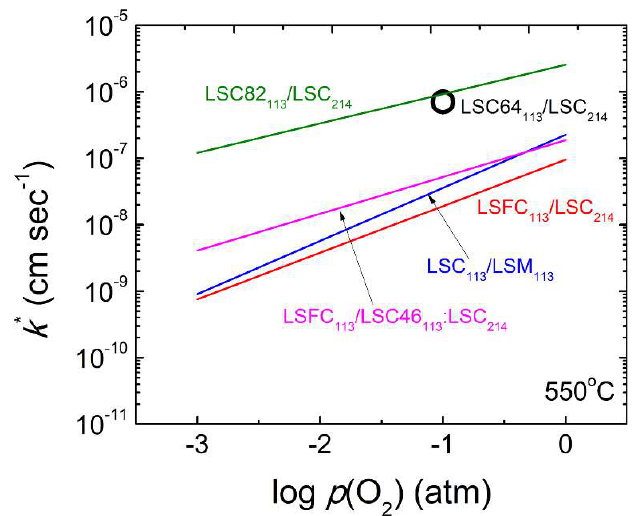
Figure 11. Arrhenius plots of surface exchange coefficients (k*) for various heterostructure oxide thin films. Effect of heterostructure interfaces on k * for La 0.6 Sr 0.4 CoO 3-δ /(LaSr) 2 CoO 4±δ [150], La 0.625 Sr 0.375 Fe 0.75 Co 0.25 O 3- δ /(LaSr) 2 CoO 4±δ [86], La 0.8 Sr 0.2 CoO 3-δ /La 0.8 Sr 0.2 MnO 3-δ [76], La 0.8 Sr 0.2 CoO 3-δ /(LaSr) 2 CoO 4±δ [148] and La 0.6 Sr 0.4 Fe 0.8 Co 0.2 O 3-δ /La 0.4 Sr 0.6 CoO 3-δ :(LaSr) 2 CoO 4±δ [66].